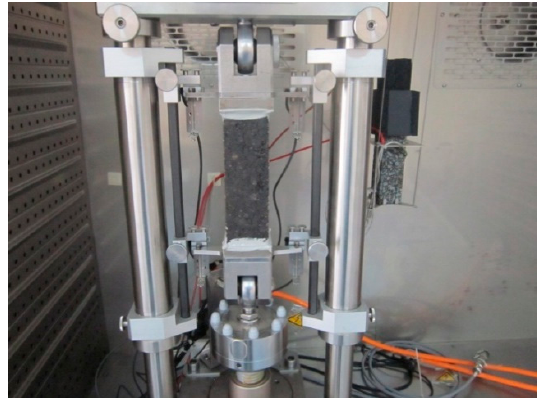
Figure 8. Equipment for testing of asphalt concrete sample at direct tension.